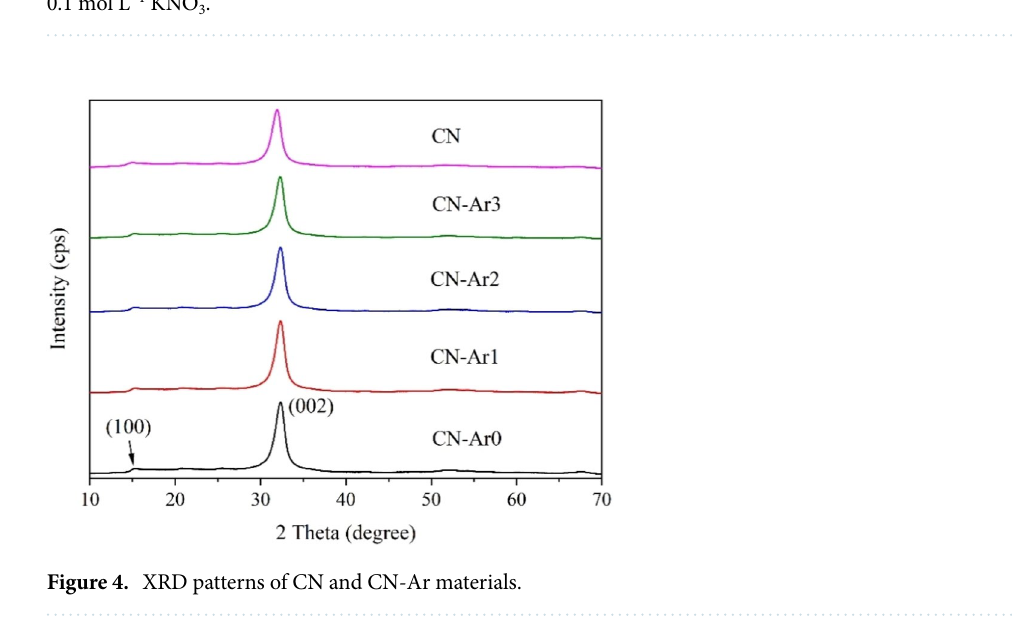
Figure 3. Photocurrents of CN and CN-Ar materials recorded at 1 V versus Ag/AgCl in deoxygenated 0.1 mol L −1 KNO 3 .